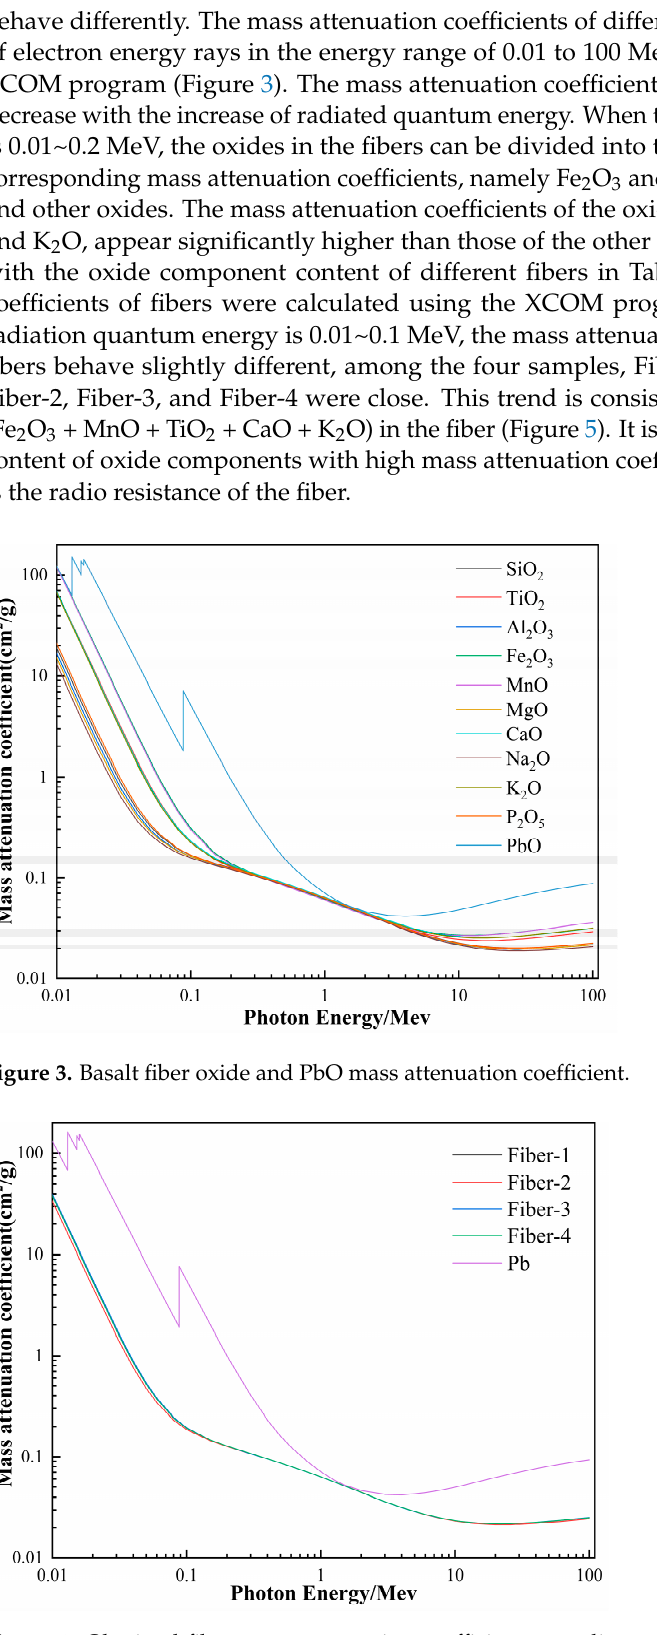
Figure 4. Obtained fiber mass attenuation coefficient according to different oxide content (Pb as a